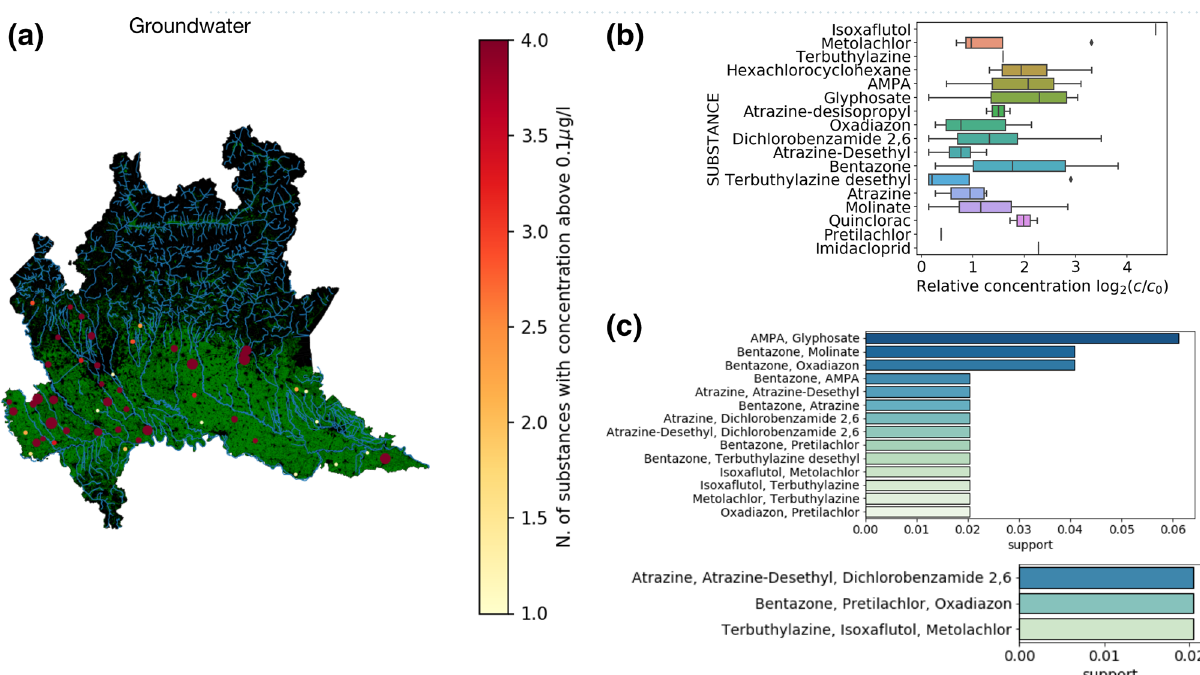
Figure 4. Clusters of substances in groundwater. ( a ) Map showing the sites where herbicides and insecticides have been found with c > c 0 = 0.1 μg/l. The color code of the marker represents the number of substances found in the same location at the same time. Cultivated areas are colored in green and rivers in cyan. ( b ) The distribution of relative concentrations c / c 0 (only when c > c 0 ). Error bars in the boxplot are 1.5 of the inter-quartile range. ( c ) Fraction of instances in which three substances have been recorded (all with c > c 0 ) in the same location at the same time. ( d ) Fraction of instances in which three substances have been recorded (all with c > c 0 in the same location at the same time). The map was created in python3.7 using the geopandas (0.6.1) package (https:// geopa ndas.